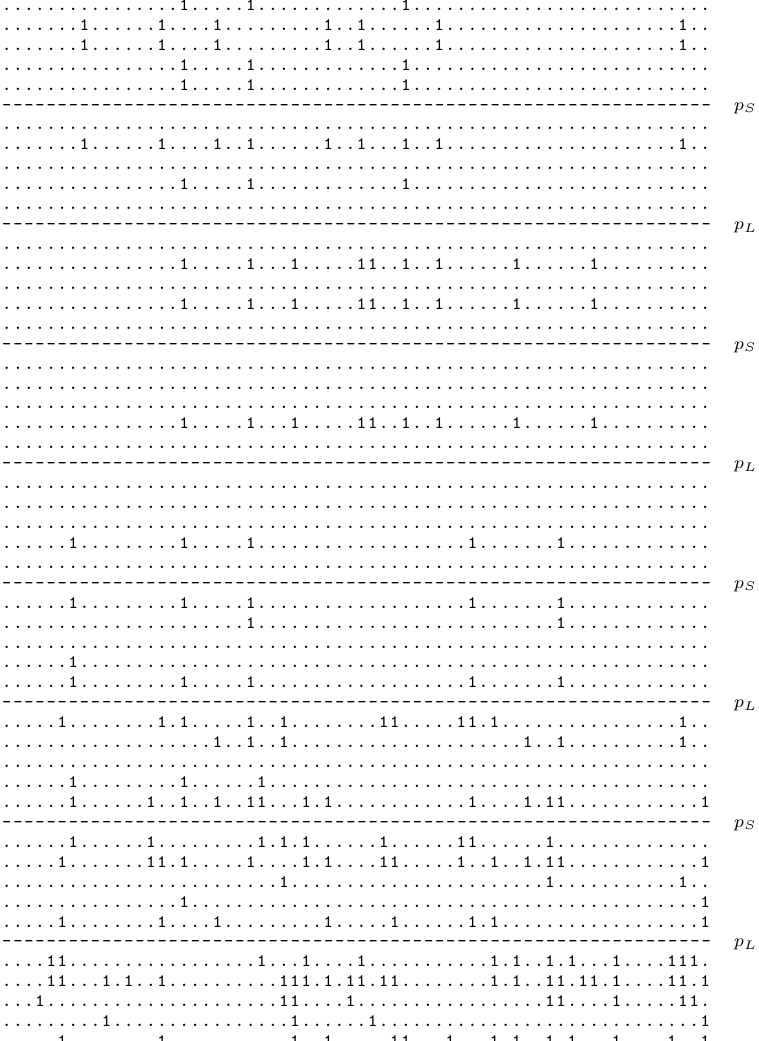
Figure 9: 5-round trail with 75 [10, 9, 5, 21, 30] active Sboxes and weight 223 [20, 36, 15, 60,